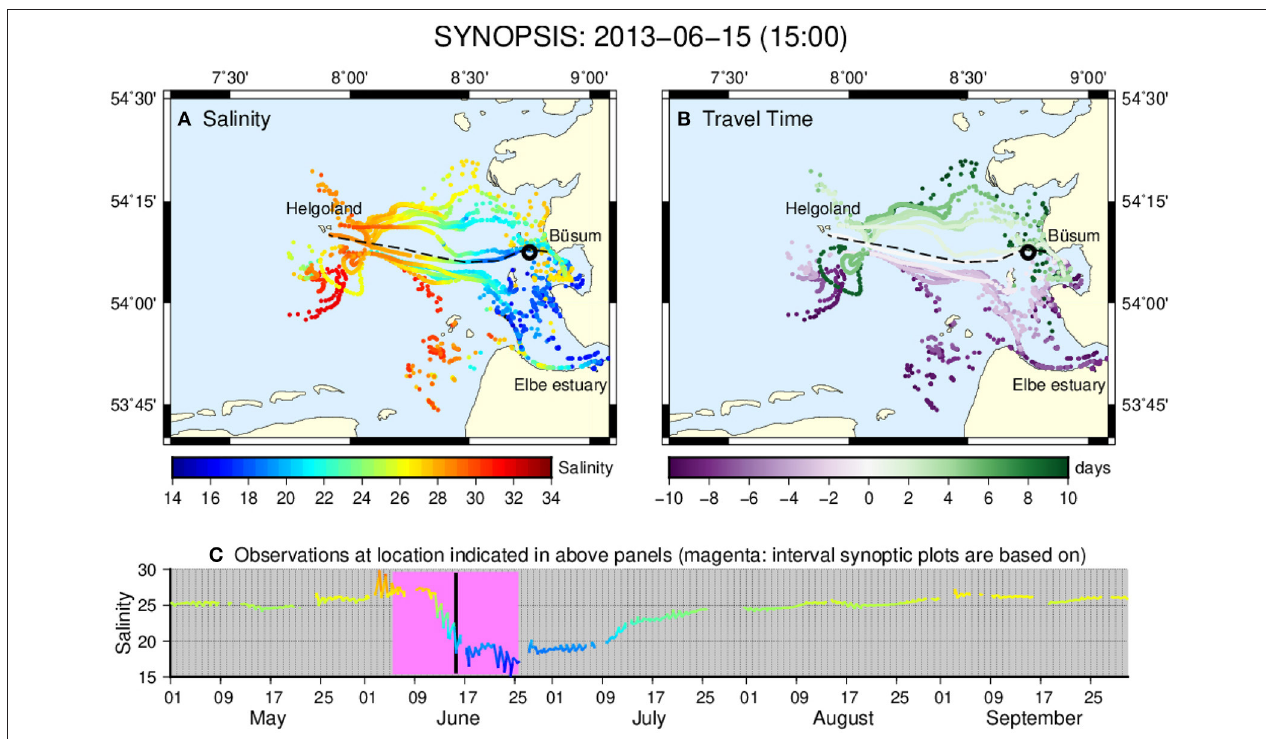
FIGURE 4 | (A) Synopsis of salinity data collected within the period June 15, 2013 (15:00) UTC ± 10 days. Drift trajectories were calculated based on surface currents from BSHcmod. (B) Differences between the time of the synopsis and times of observations. Green (purple) indicates observations to be taken earlier (later) than June 15, 2013 (15:00) UTC (see the conceptual Figure 2 ). Dashed lines in panels A and B represent the ferry route along which all measurements were taken. (C) Time series of FerryBox observations at the location indicated by black circles in (A,B). The vertical black line indicates the time of the synoptic plot, and the magenta colored bar covers the time interval from which data contribute. An animation of this figure is provided as a Supplementary Video 1